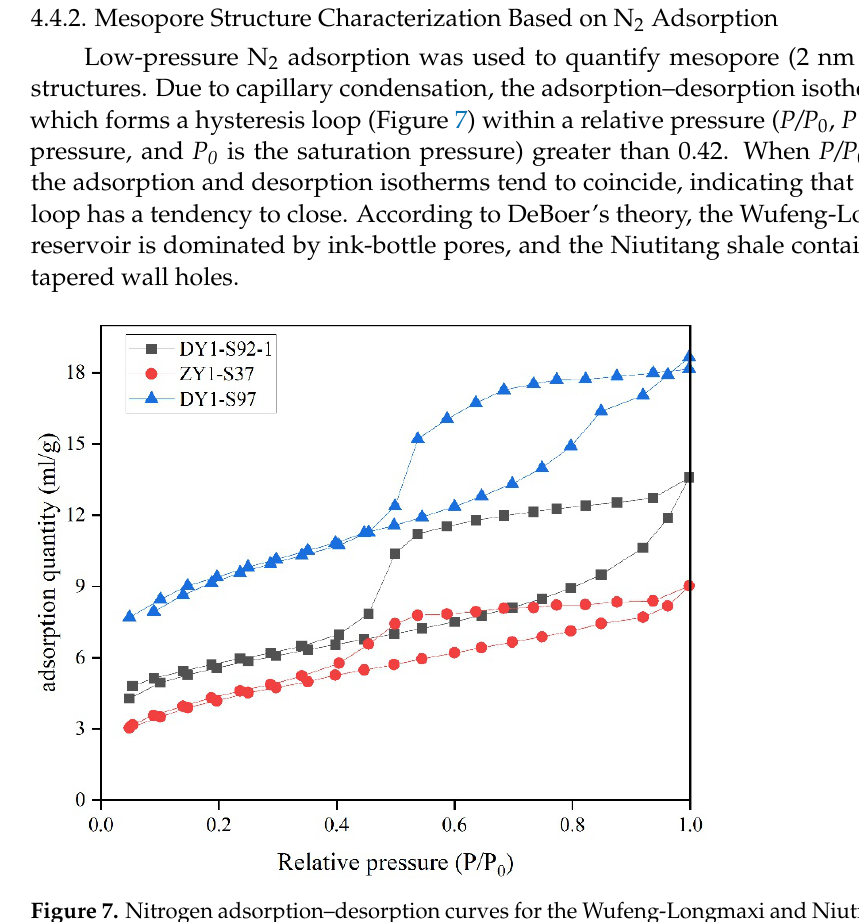
Figure 7. Nitrogen adsorption–desorption curves for the Wufeng-Longmaxi and Niutitang For- mation shales in northern Guizhou Province.